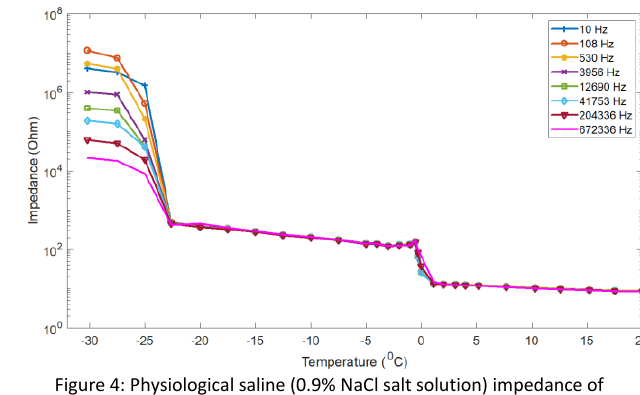
Figure 4: Physiological saline (0.9% NaCl salt solution) impedance of selected frequencies as a function of temperature measured during